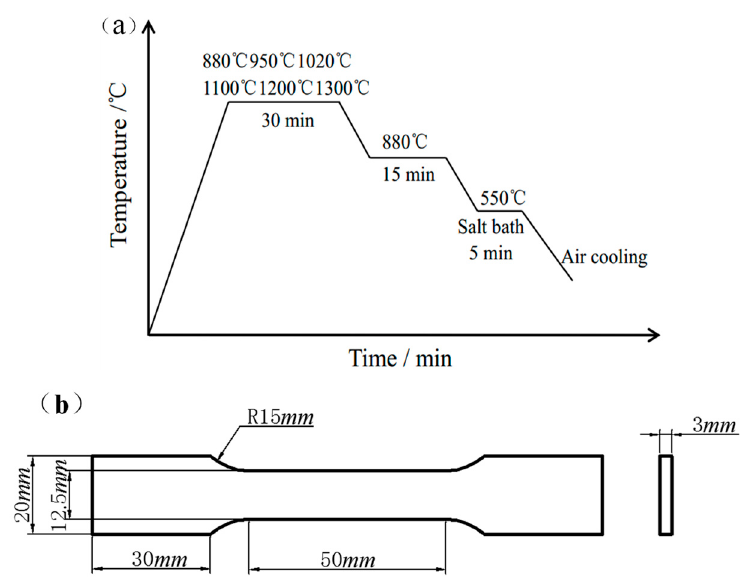
Figure 1. ( a ) Process diagram of the heat treatment and ( b ) size of plate structural samples for the tensile test.